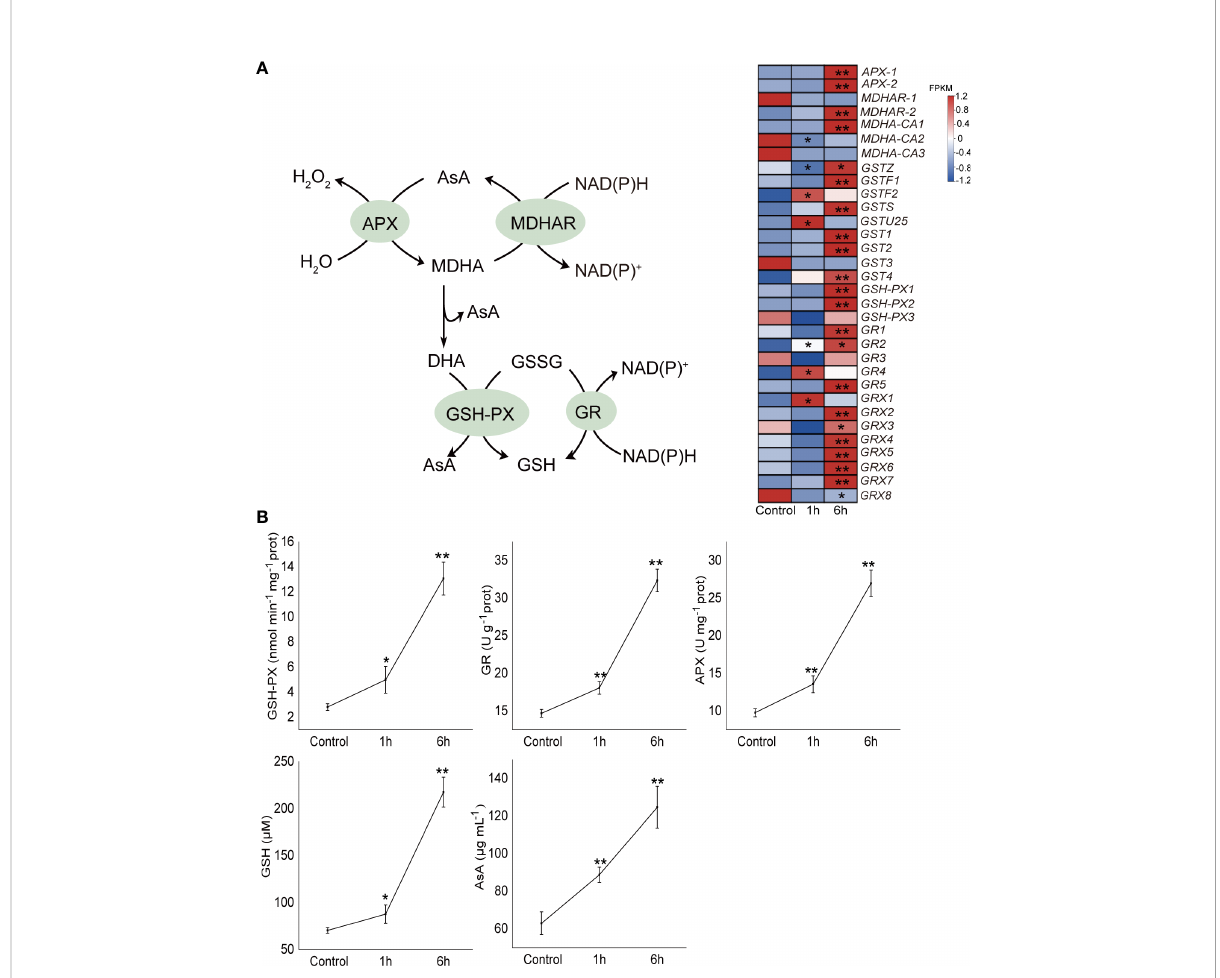
FIGURE 4 Effect of exogenous abscisic acid on the ascorbate (AsA)-glutathione (GSH) antioxidant system of Neoporphyra haitanensis. (A) Heatmaps of the transcriptional patterns of AsA-GSH antioxidant pathway genes in response to abscisic acid (ABA) treatment. The data shows the transcriptomic pro fi les from the control, 100 m M ABA 1 and 6 hour groups. FPKM values of genes in different groups were used to construct the heatmaps after a z-score normalization (n = 3). (B) Effect of ABA on the antioxidant enzyme activities and antioxidant concentrations in N. ha itanensis . Thalli were treated with 100 m M ABA for 1 and 6 hours, respectively. The samples were collected for enzyme activity analysis. APX, ascorbate peroxidase; GR, glutathione reductase; GPX, glutathione peroxidase. * P < 0.05, ** P < 0.01 when compared to control